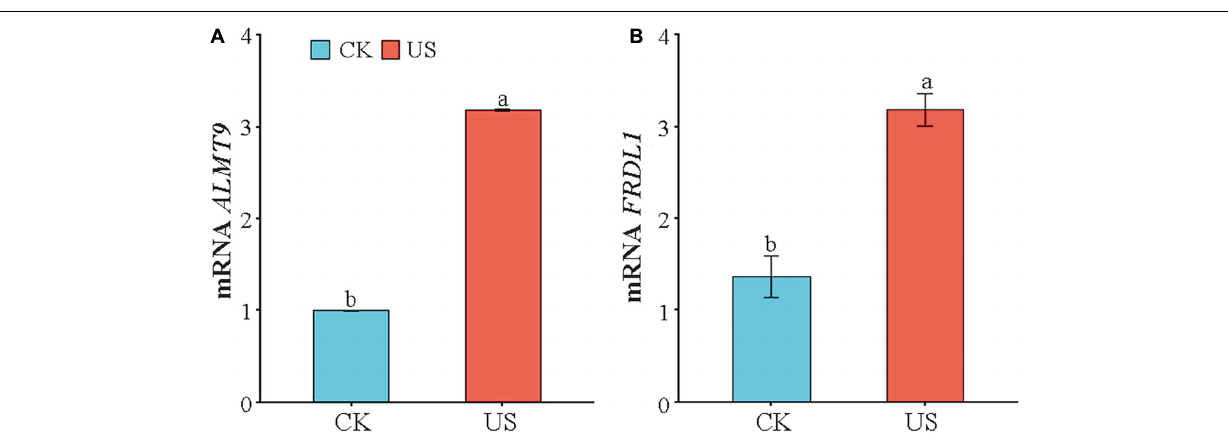
FIGURE 3 | Analysis of transcript levels of (A) ALMT9 and (B) FRDL1 . Marking the same letters means P ≥ 0.05 (LSD), and there is no significant difference; the difference between different letters means P < 0.05 (LSD), and the difference is